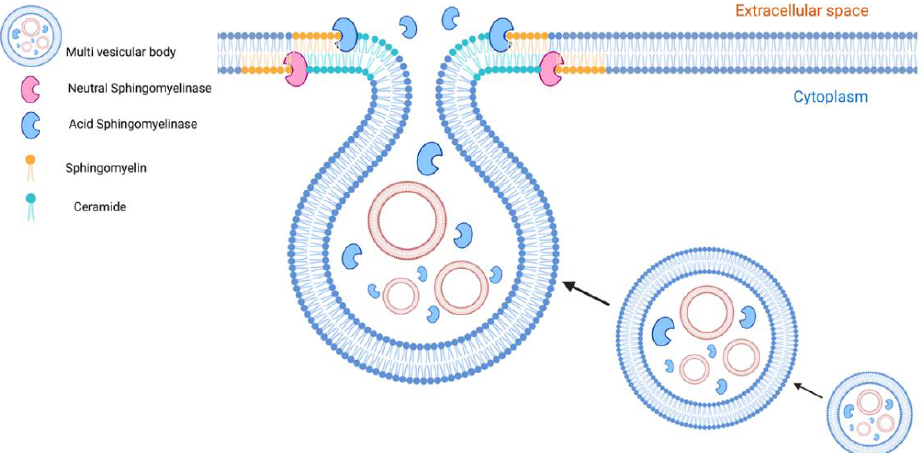
Figure 5. Role of sphingomyelinases and ceramides in EV formation. Sphingomyelinases are active at the level of endosomes and cell membranes whereas their natural products, ceramides, are involved in the biogenesis and secretion of EVs. Neutral sphingomyelinase (nSMase) and ceramides participate in the endosomal formation of exosomes in an ESCRT-independent pathway. Acid sphingomyelinases (aSMase) targeted directly or indirectly via lysosomal exocytosis to the cell membrane contribute to creating ceramide-enriched microdomains that are involved in microvesicle and exosome formation and secretion.